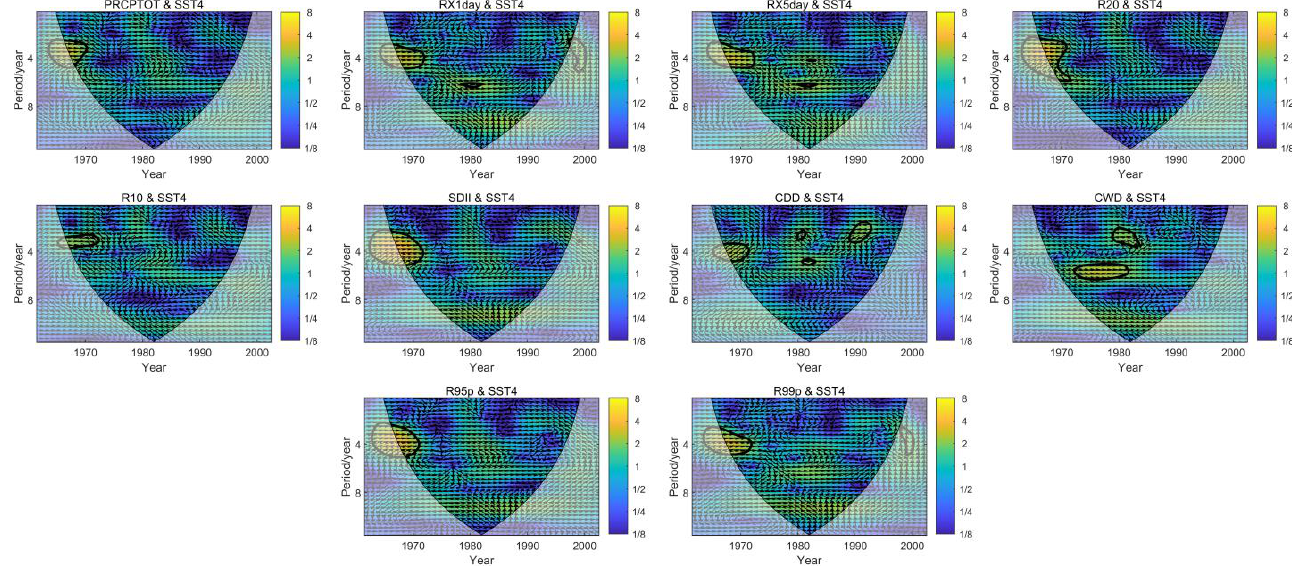
Figure 11. Correlations between the MEI and EPIs on a yearly scale. A bold black contour represents the 95 percent significance threshold against red noise; a thin black line represents the cone of influence (COI) and bold arrows reflect phase change.